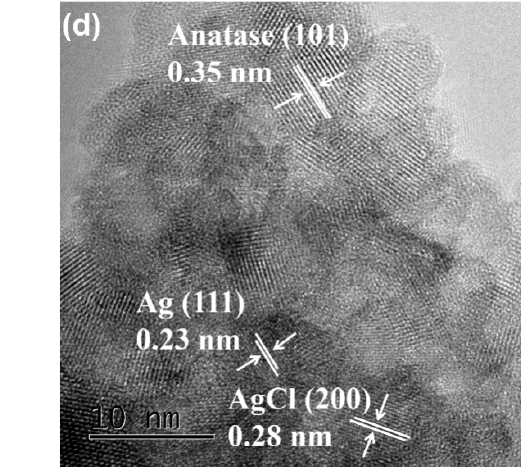
Figure 3. TEM and HRTEM images of ( a , c ) pure TiO 2 and ( b , d ) 4%Ag-TiO 2 .